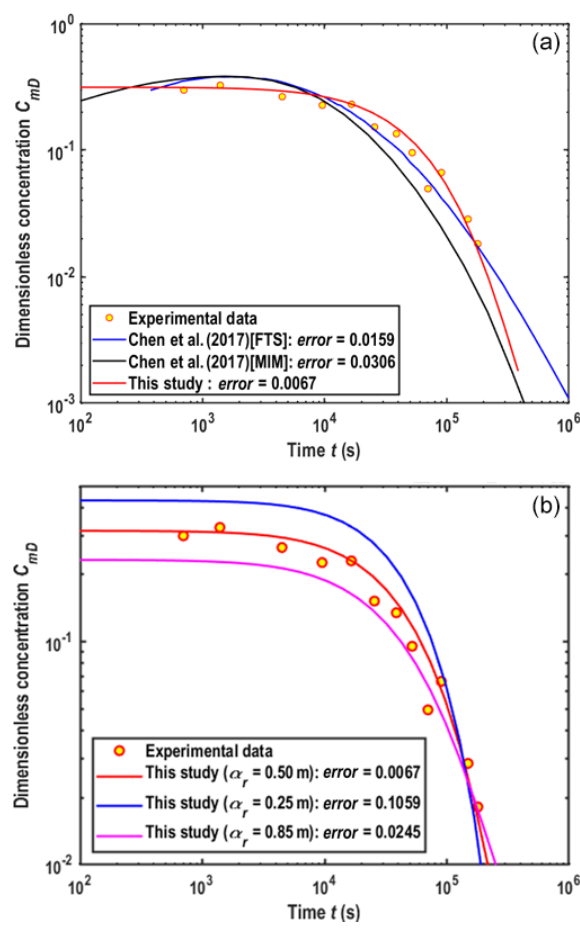
Figure 8. Fitness of observed BTC. (a) Fitness of the observed data by different models. (b) Influence of the dispersivity of the aquifer on